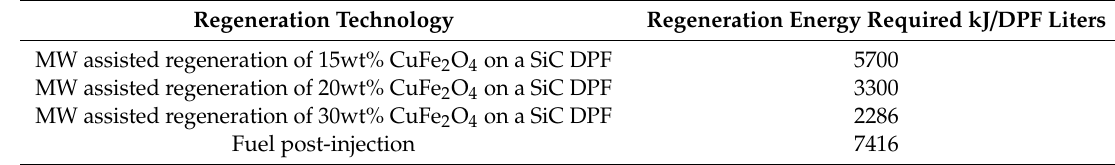
Table 4. Comparison of energy consumption during Diesel particulate filter (DPF) regeneration